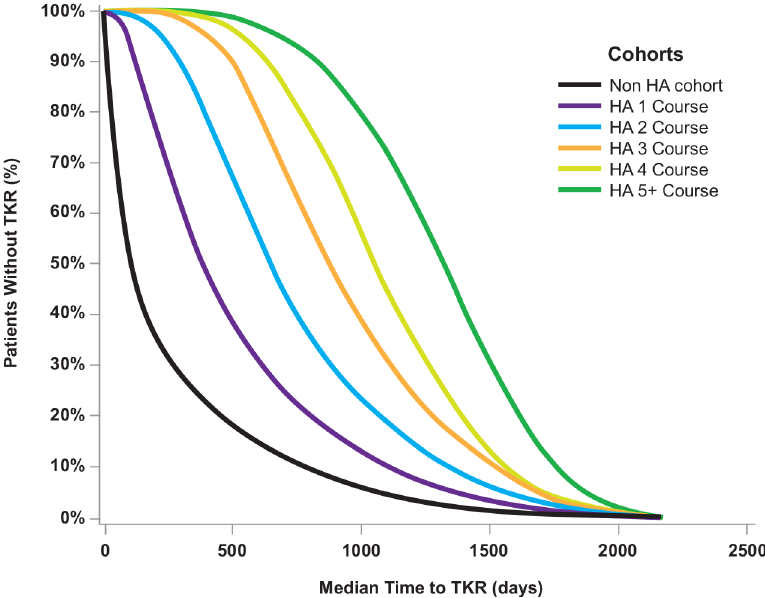
Fig 2. Time-to-TKR as a function of number of courses of HA injection. Each individual comparison of an HA User cohort to HA Non-users was significant (p < 0.0001; see Table 3). All HA cohorts had substantially longer time-to-TKR than HA Non-users (all, p < 0.0001), with the weakest significance for patients who got only 1 course of HA injection ( χ 2 = 13,724.6; p <